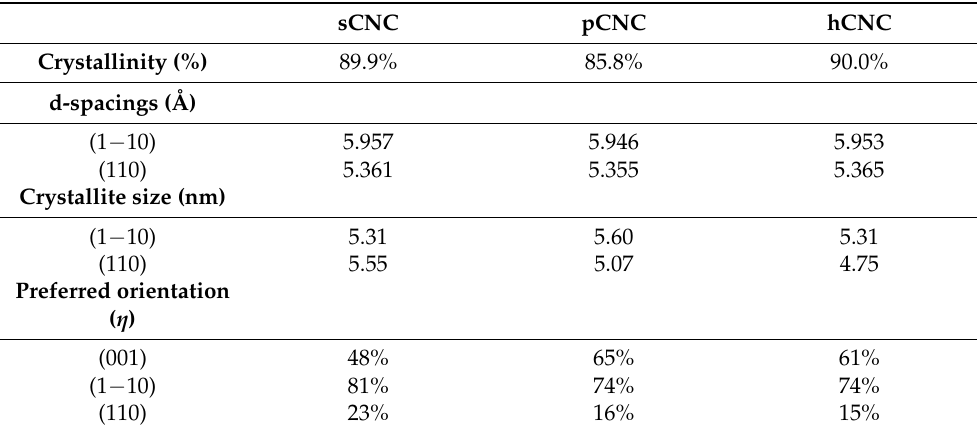
Figure 7. ( a ) Experimental diffraction patterns for lyophilized CNC powder, and ( b – d ) results of Rietveld refinement of the entire diffraction pattern for each nanocrystalline material. Table 2. Results of Rietveld refinement using MAUD for crystallinity index, d-spacings, crystallite sizes, and preferred